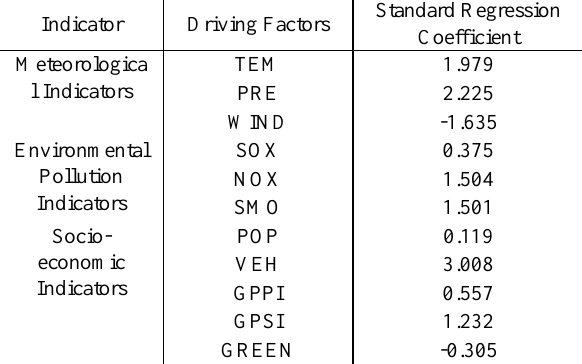
Table 3. The standard regression coefficient of the